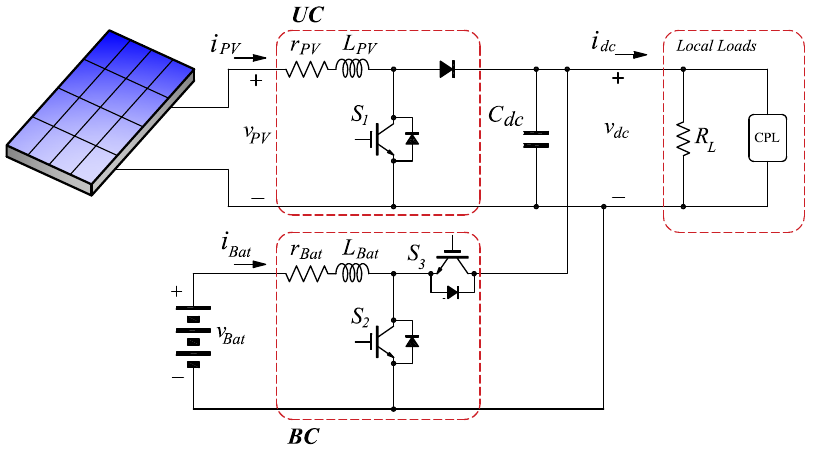
Figure 2. Electric circuit of an isolated DC